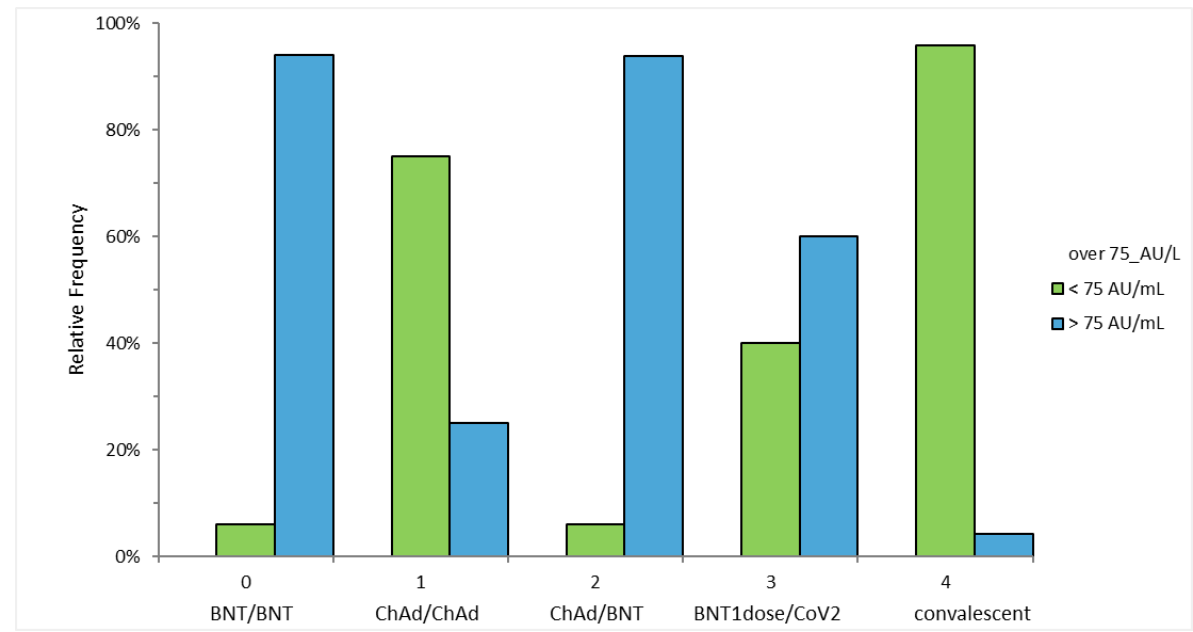
Figure 2. Proportion of subjects reaching an anti-S-RBD titer over 75 AU/mL across study groups.